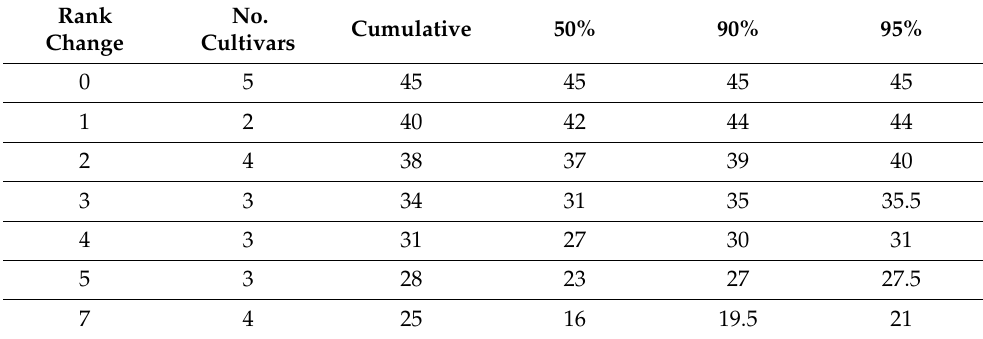
Table 11. Absolute yield rank differences for the 2011 trial. Number of cultivars shows the number of cultivars with the given rank change and Cumulative shows the number with that rank change or greater. The 50%, 90% and 95% points are from the simulated distribution variables and show the distribution of the number of cultivars that exhibited an absolute rank change at least as large as that specified due to random variation, as described in the text. Rank No. Cumulative 50% Change Cultivars